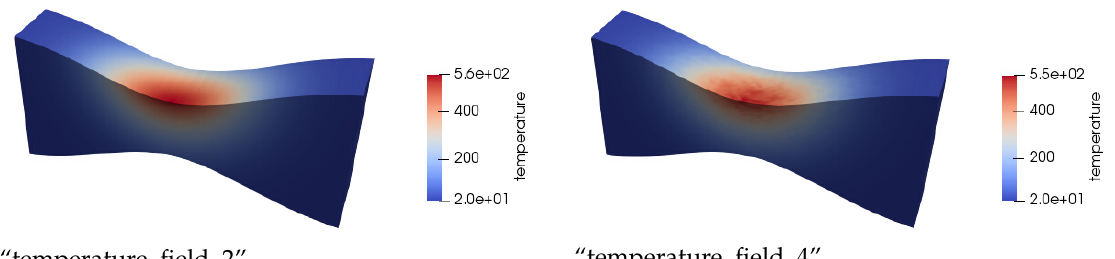
Figure 6. Two different variabilities for the temperature loading (in ◦ C) used in the academic test case.